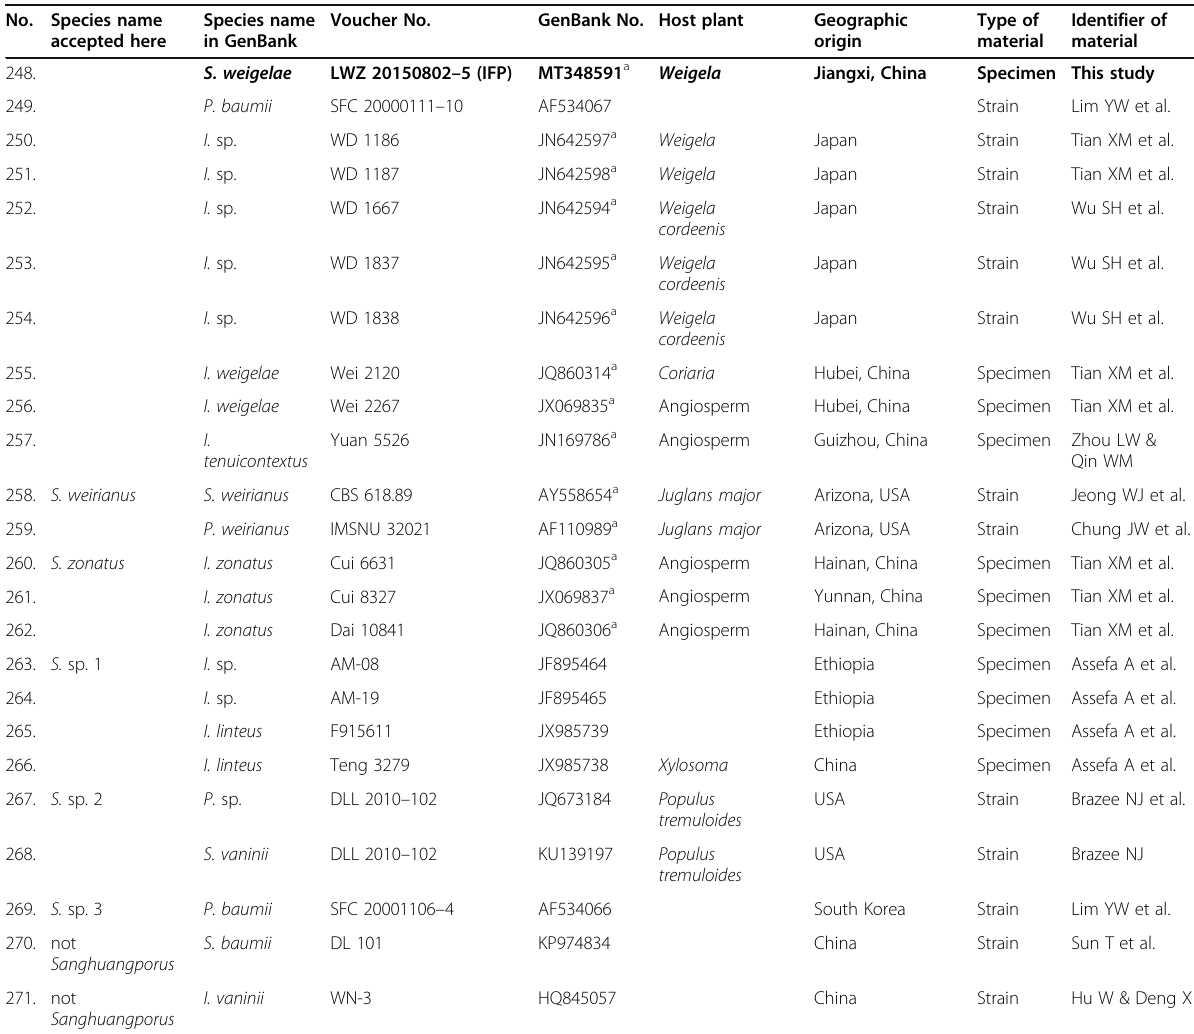
Table 1 Information of analyzed ITS sequences of Sanghuangporus (Continued)